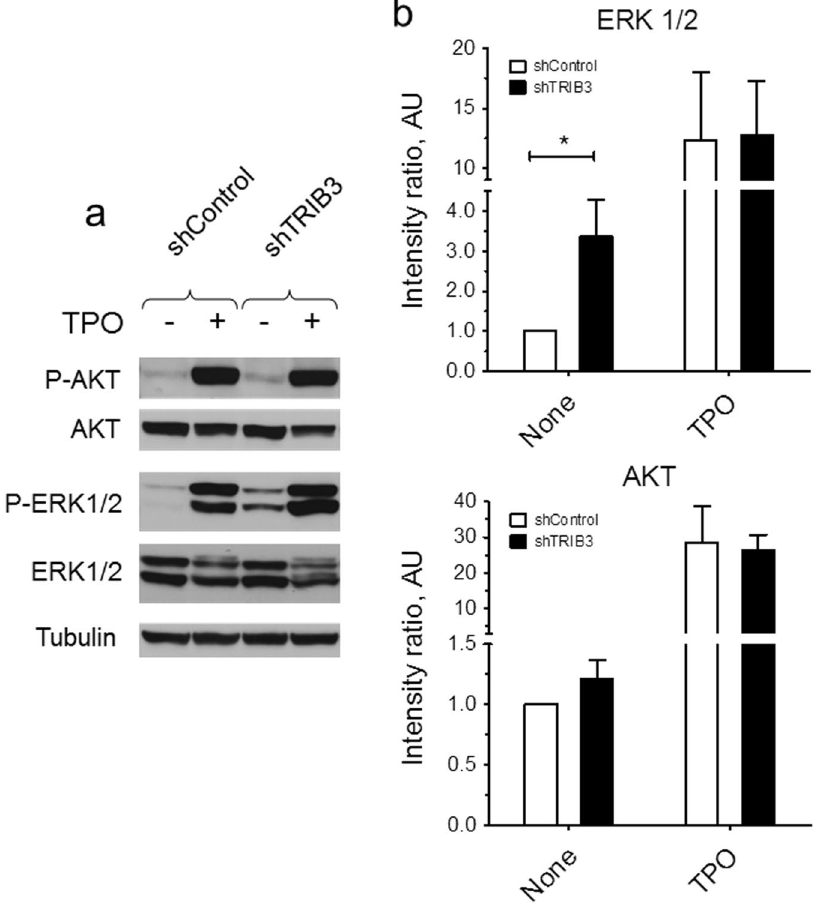
Figure 6. TRIB3 silencing enhances the basal levels of ERK1/2 phosphorylation in UT7/mpl cells. shRNA- transduced cells were incubated for 30 min in the absence or presence of 100 ng/mL TPO and then analysed for AKT and ERK1/2 phosphorylation. Phosphoproteins were detected by immunoblotting and quantified by scanning densitometry. A representative immunoblot is shown in ( a ); quantification is shown in ( b ). Relative phosphorylation levels were calculated as the ratio of the intensity of the phosphorylated polypeptide bands to the intensity of the corresponding total polypeptide bands. Results are expressed relative to the level of phosphorylation measured in unstimulated shControl cells. Error bars denote SD of three independent cultures. * P <